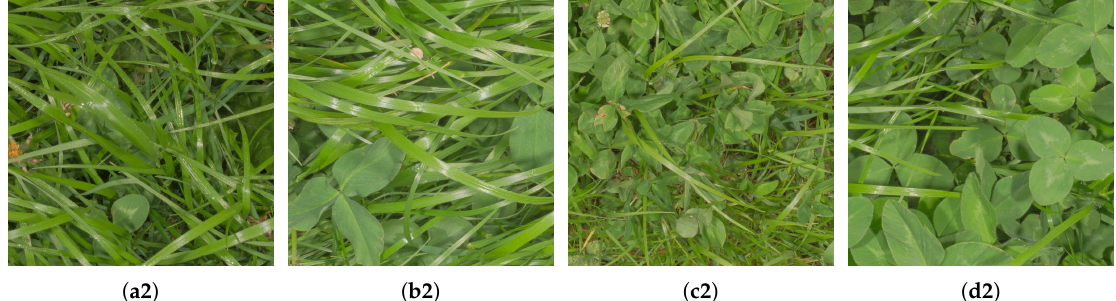
Figure 4. Visualization of annotated image samples. Top row shows four samples with different clover contents. Bottom row shows crops of the images from the top row to illustrate the image resolution. The black pixels surrounding the image samples mark the border of the harvested samples. When the orientation of the camera does not align perfectly with the harvested patch, the image sample appears to be rotated. ( a1 ) 5% clover; ( b1 ) 20% clover; ( c1 ) 50% clover; ( d1 ) 70% clover; ( a2 ) Annotated image patch of (a1); ( b2 ) Annotated image patch of (b1); ( c2 ) Annotated image patch of (c1); ( d2 ) Annotated image patch of